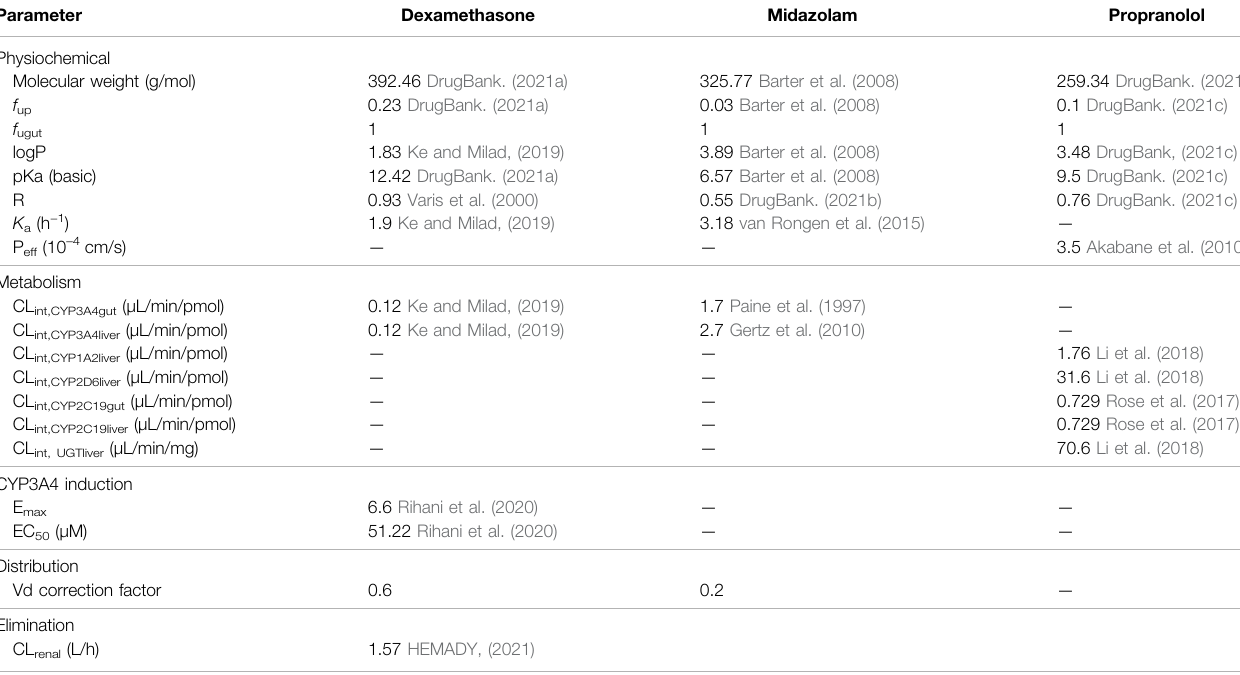
TABLE 2 | Physiochemical and pharmacokinetic characteristics of dexamethasone, midazolam, and propranolol.